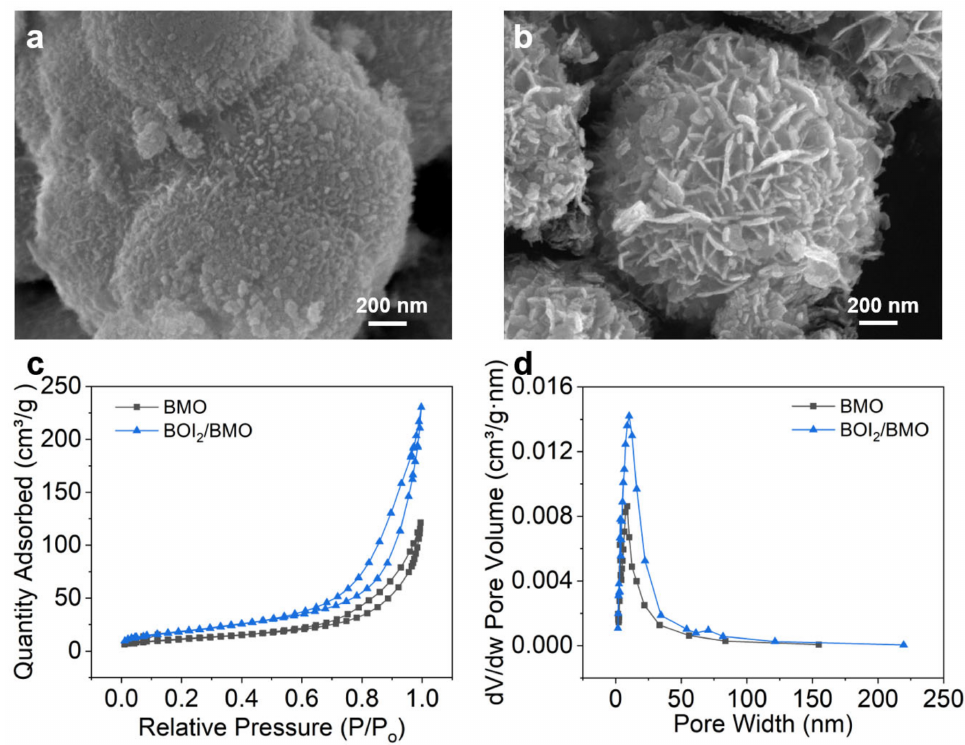
Figure 3. SEM micrographs of ( a ) BMO and ( b ) BOI 2 /BMO. ( c ) N 2 adsorption–desorption isotherms and ( d ) pore size distribution curves.